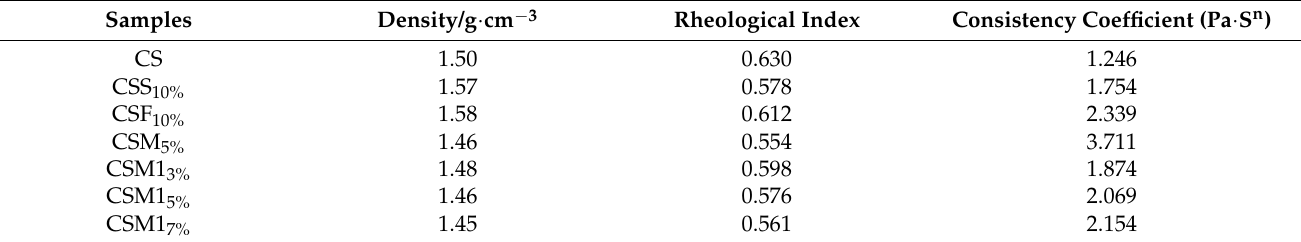
Table 5. Physical properties of